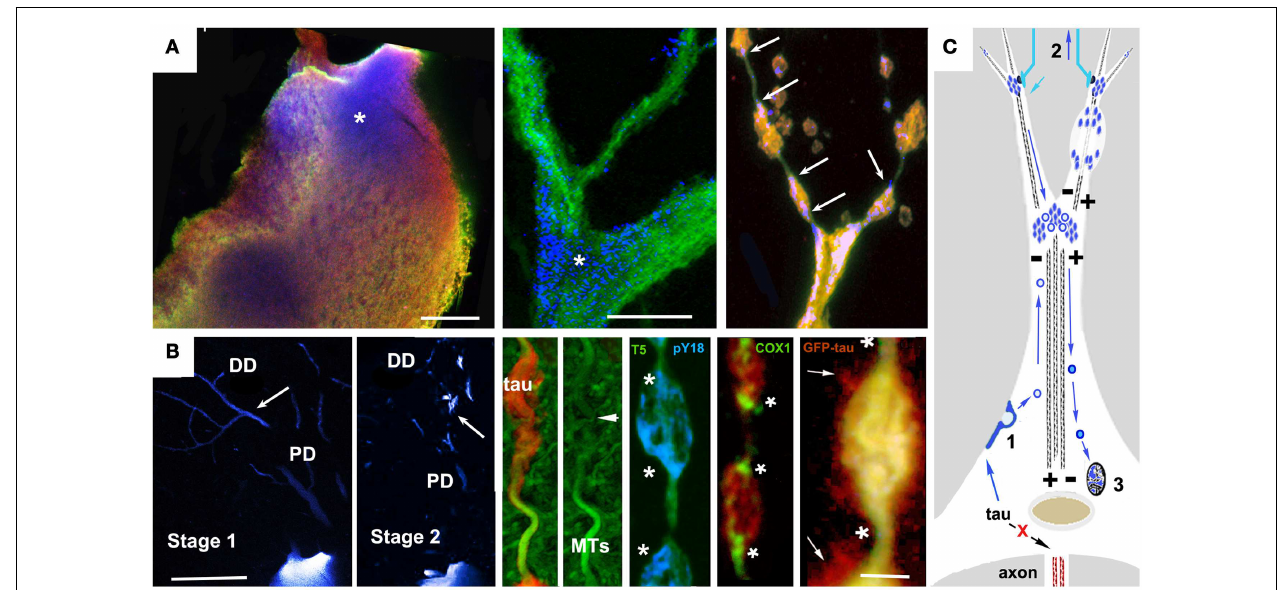
in the accumulation of pY18 (fyn phosphorylated) tau associated with vesicles and membrane-bound organelles.The accumulation of mitochondria (COX2 label) is particularly well marked.With the onset of dendritic degeneration, total and pY18 + tau accumulates at each end and eventually in the center of dendritic varicosities in what appear to be MT-transported vesicles.The localized secretion occurring in the vicinity of such deposits suggests that tau-bearing vesicles first destabilize the MTs responsible for their transport, accumulate in the resulting varicosities and are then secreted.While the mechanism responsible for this has not been demonstrated directly, the concomitant loss of MTs and localized secretion suggests a Ca ++ flux mediated mechanism. (C) A model for vesicle-associated tau in NFT formation and cytodegeneration. Failure of tau to become axonally localized and bind axonal MTs results in actin association and endocytosis (1). Tau-bearing vesicles are transported both distally and proximally on dendritic MTs, accumulating at dendritic branch points (where MT polarity patterns favor localized cargo accumulation Aronov 01) and near synaptic terminals (2), where it may become locally toxic possibly via interacting with Abeta in synapse-associated endosomes, resulting in structural failure of dendrites (top right) and uptake by afferents resulting in retrograde trans-synaptic movement. Synaptic activity may also result in the centripetal transport